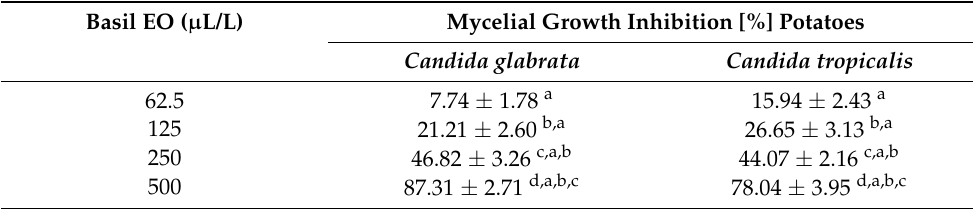
Table 9. In situ analysis of the anti-yeast activity of the vapor phase of OBEO on potatoes. Basil EO ( µ L/L)